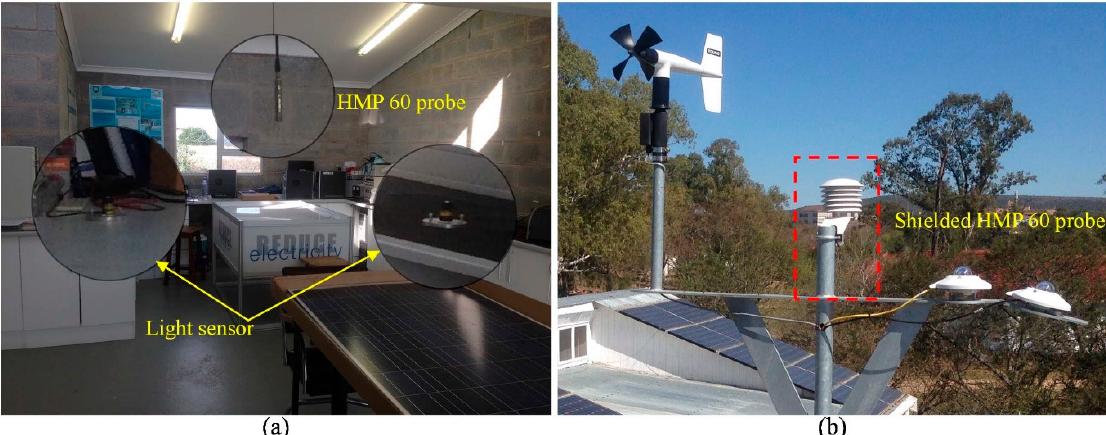
Figure 3. ( a ) Inner space of the office indicating the HMP60 temperature and relative humidity probe and photometer sensor; ( b ) a setup outdoor weather station indicating the shield HMP60 temperature and relative humidity